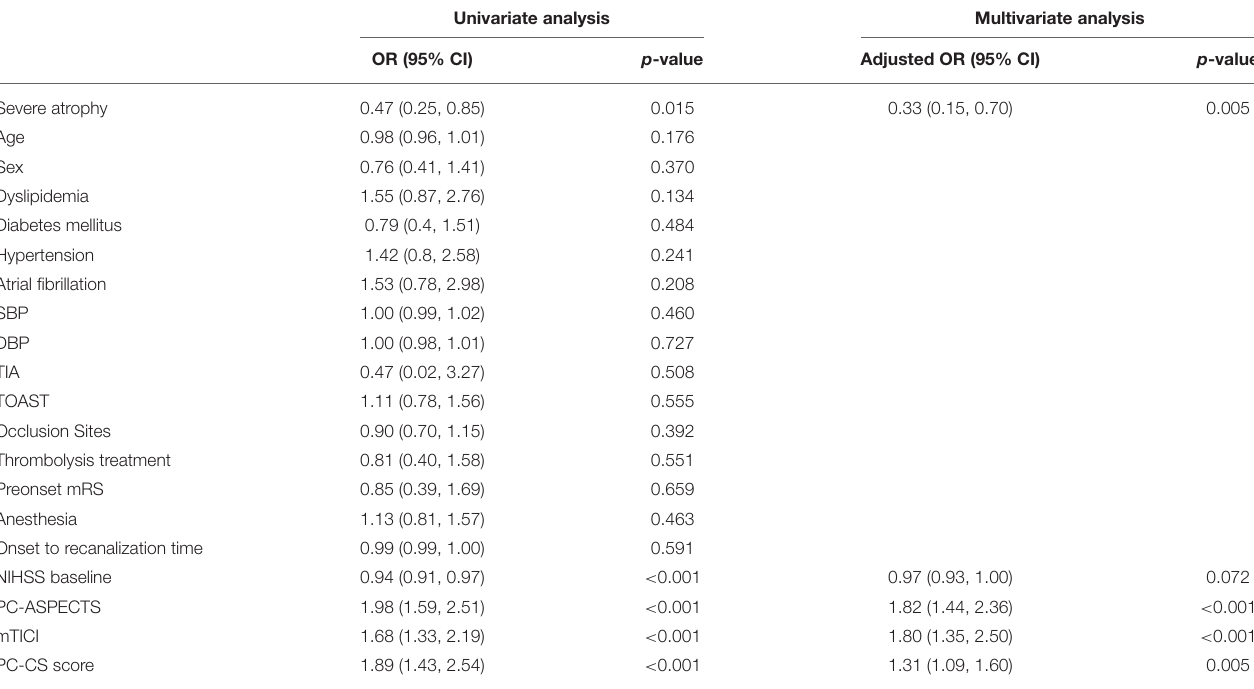
TABLE 4 | The association of severe brain atrophy and traditional risk factors in predicting outcome.